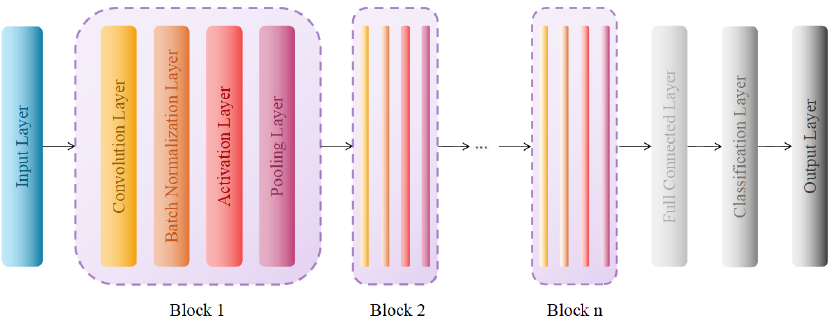
Figure 1. Typical fully connected CNN network architecture.